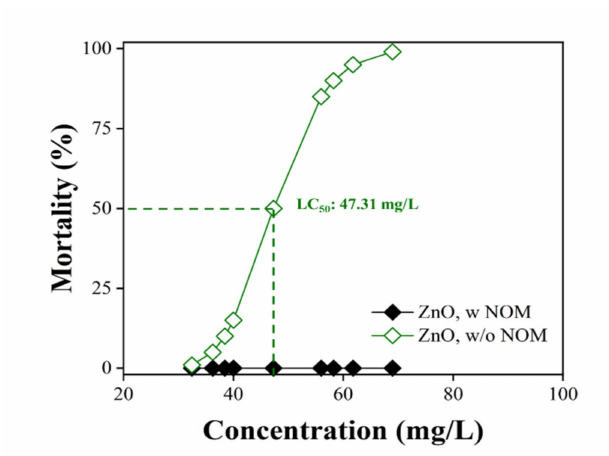
Figure 9. Oryzias latipes mortality by ZnO NPs with / without